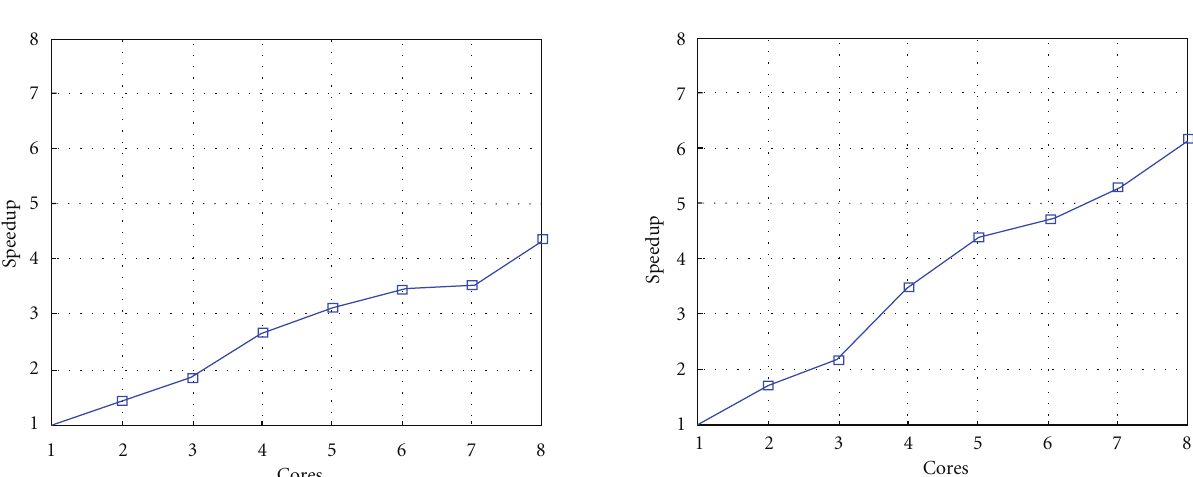
Figure 10: Test 1: Algorithm SI: Speedup versus the number of cores. Δ τ = 0 . 16. 3 scale steps.